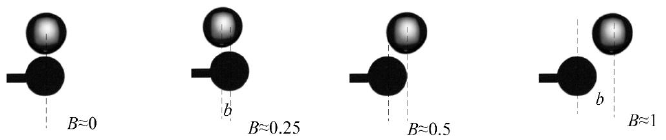
Figure 2. Images of droplet–particle interaction from different positions of the video camera and at different values of B [49]. The characteristics of secondary droplets resulting from the disruption of the initial droplet were examined. For that, the radii ( r d ) and number ( N ti ) of all the visible (i.e., within the recording area) secondary fragments were measured. The volume of the initial droplet was calculated: V 0 = 4·π·( R d13 + R d23 )/3. The total volume of a group of resulting child droplets was given by V 1 = 4·π·Σ r di 3 /3. The difference between these volumes was the volume of liquid remaining on the particle surface. 3. Results 3.1. Collisions of Liquid Droplets with Solid Particles In the experiments, the main patterns of the interaction of liquid droplets with solid particles (being the components of promising composite fuels) were established. Figures 3 and 4 present typical images of the collisions of water and oil droplets of different initial sizes ( R d = 1 – 2.2 mm) with the carbonaceous particles of coking coal filter cake with R p = 0.75 – 1.5 mm (for a series of varying droplet sizes). The images show that the key param- eter affecting the occurrence of stretching separation and formation of child droplets at an identical velocity is the particle – droplet size ratio (Δ). Stretching separation proceeded when the kinetic energy of the liquid droplet movement was greater than the sum of en- ergies used to overcome viscous friction, dissipation energy, rotational energy and the energy used to overcome the surface tension forces. If the kinetic energy was greater than the sum of energies, the liquid fragments separated from the solid particle. Otherwise, the liquid droplet remained on the solid particle (agglomeration was recorded). It is clear from Figure 3a,b that at a liquid droplet size R d of 1.45 mm, stretching separation is bound to occur after the collision with carbonaceous particles with a size R p of 0.75 – 0.9 mm. The collisions of such droplets with dry particles resulted in the formation of several child droplets. With a reduction in the initial droplet size R d to 1.1 mm (Figure 3a,b), agglom- eration was recorded. Here the droplet stuck to the carbonaceous particle and enveloped it. The liquid layer was not detached. Agglomeration occurred irrespective of whether the particle surface was dry or wet. Agglomeration was recorded both for dry and wetted particles. This result is extremely important for the technologies of composite fuel droplet preparation, since coals have different moisture content, and particles can be wetted us- ing different methods.